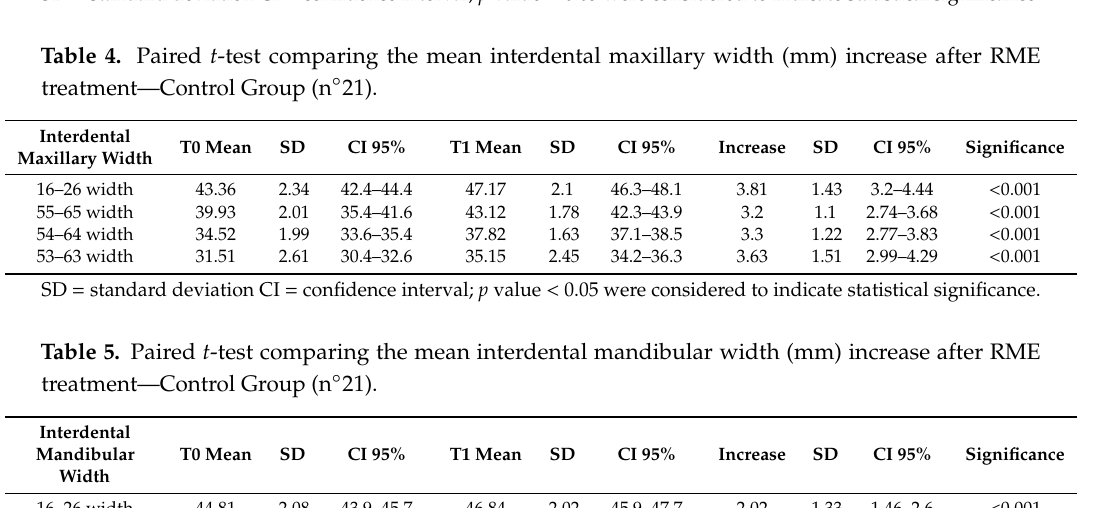
SME—test group: all the interdental widths of the maxilla (Table 2) increased significantly: first permanent molars + 2.51 mm (SD 1.58 mm), second primary molar + 5.06 mm (SD 0.98 mm), Table 3, even the mandibular interdental width of the test group increased significantly: intermolar width increased by 1.24 mm (SD 1.09 mm), first primary intermolar 1.63 mm (SD 1.57 mm), second primary intermolar by 0.93 mm (SD 1.08 mm), intercanine width 1.03 mm (SD 1.25 mm). RME—control group: all the interdental widths increased significantly in both arches and are shown in Tables 4 and